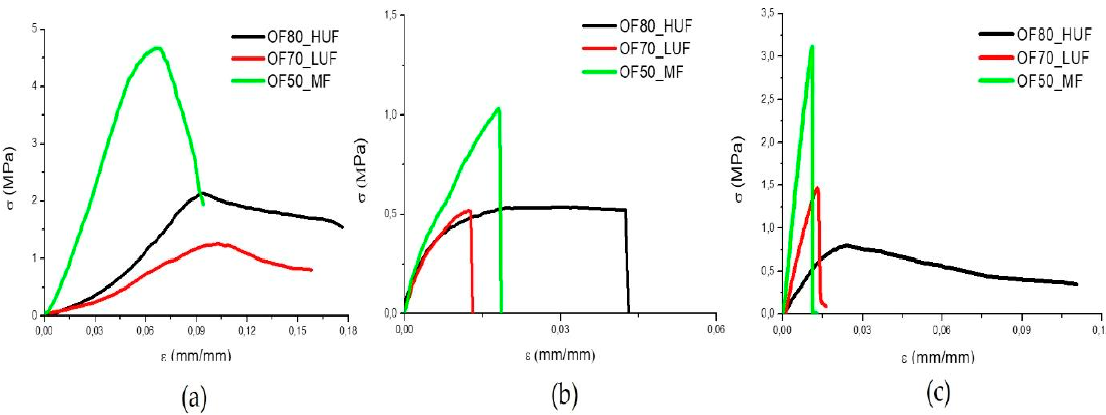
Figure 3. ( a ) Compression, ( b ) tensile, and ( c ) flexural tests on samples realized with different resins . Table 3. Mechanical tests results ( σ R is the samples strength, ε R the strain at break, E the modulus and ρ the density).